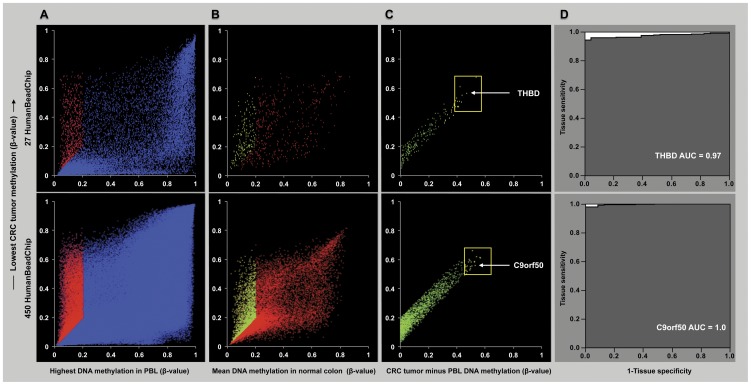
Scatterplot representation of marker discovery process and ROC curves.A (top figure: HM27, bottom figure: HM450), scatterplots of the highest PBL β-value (β-PBLH) of 10 (HM27) and 2 (HM450) healthy control samples (X-axis) against the associated 10th percentile of CRC tumor β-values (β-CRC10) on the Y-axis. The blue dots represent the eliminated probes (HM27: n = 23,049; HM450: n = 367,833) and the red dots (HM27: n = 695; HM450: n = 30,207) represent the retained probes with a β-CRC10>β-PBLH or a β-PBLH<0.2. B, scatterplots of the mean normal colon tissue β-value (β-NCM) for the retained probes from Panel A (X-axis) against the associated β-CRC10 (Y-axis). The red dots (HM27: n = 512; HM450: n = 28,428) represent the eliminated probes, the green dots represent the retained probes (HM27: n = 183; HM450: n = 1779) with a β-CRC10>β-NCM or a β-NCM<0.2. C, scatterplots of the retained probes from Panel B (green) displayed by the difference between β-CRC10 and β-PBLH (X-axis) against the associated β-CRC10 (Y-axis). The dots within the yellow square are the probes selected for additional filtering against other types of cancer. The white arrows point out the probes of the two candidate markers. D, ROC curves for the probes used in the multiplex reaction based on methylation β-values of 335 independent colorectal cancer samples and 23 independent matched normal colorectal tissue samples (the DNA methylation data of these samples were not used in the marker discovery pipeline). The dark grey color is the area under the curve.